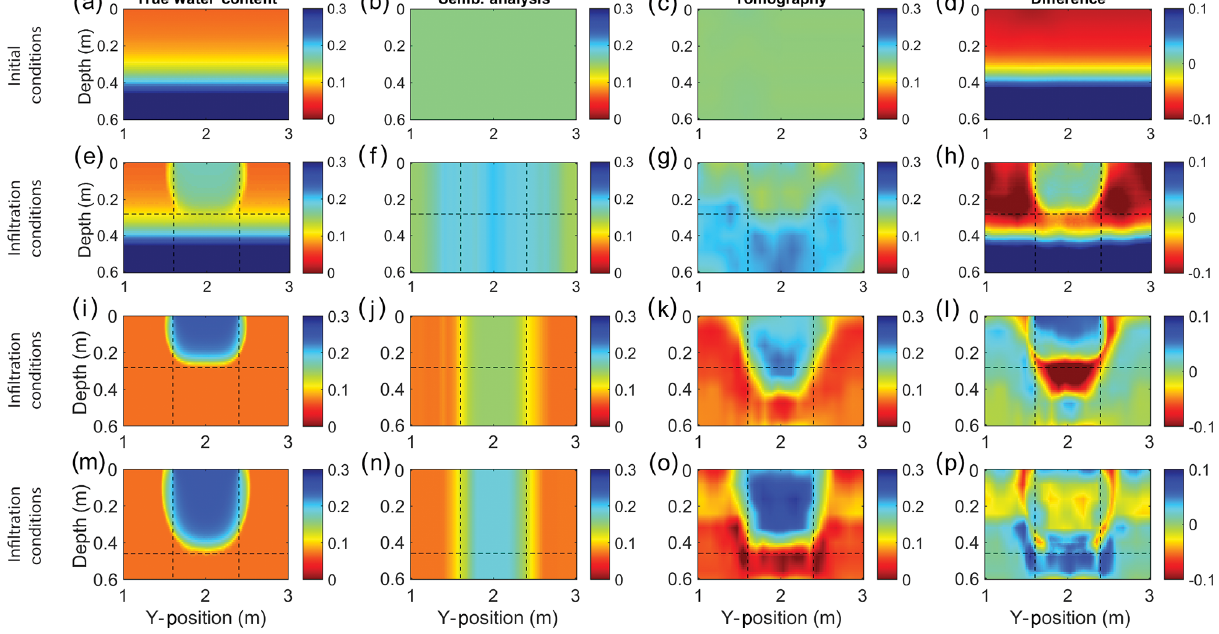
Figure 3. Panels (a) , (e) , (i) , and (m) show true volumetric water content distributions from HYDRUS-2D. Panels (b) , (f) , (j) , and (n) show starting models for the tomography derived from semblance analysis. Panels (c) , (g) , (k) , and (o) show results of tomography of the simulated GPR data as volumetric water content. Difference plots (d) , (h) , (l) , and (p) were calculated by subtracting the tomography results from the true water content distributions; red areas indicate volumetric moisture overestimation, while blue areas indicate volumetric moisture